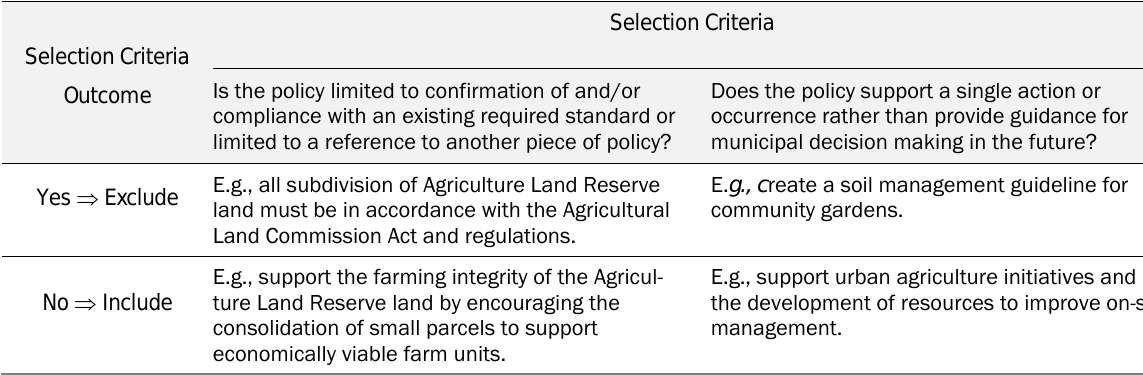
Table 1. Examples of Food Policy Statements Included and Excluded According to Inclusion Criteria